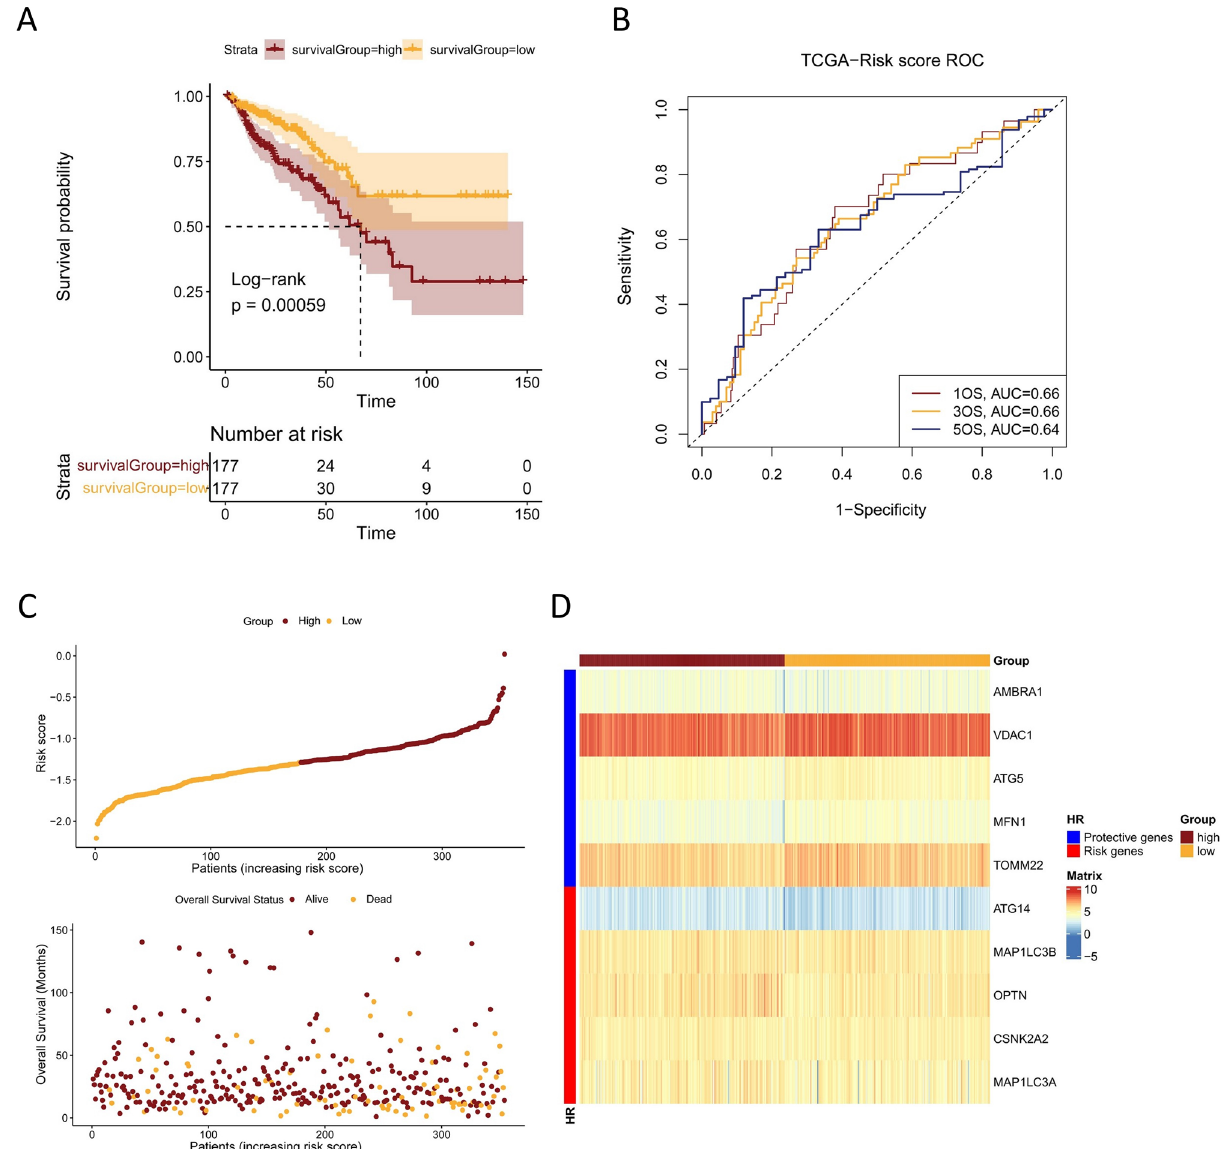
Figure 2. The prognostic value of the signature in the TCGA cohort. ( A ) Kaplan–Meier survival analysis for TCGA-CRC patients with high and low risk scores. ( B ) Time dependent ROC curve analysis of the risk score in TCGA cohort. ( C ) Risk score distribution and survival status for TCGA-CRC patients in high-risk and low-risk groups. ( D ) Heatmap of the mitophagy related genes expression profile for TCGA-CRC patients in high-risk and low-risk